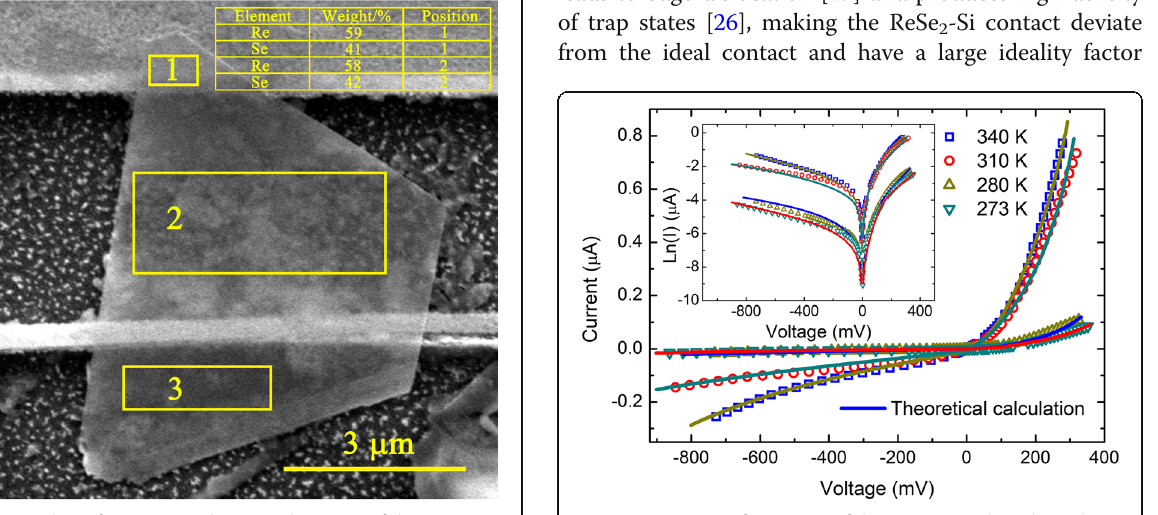
Fig. 7 Comparison of I - V curves of the experimental results and the